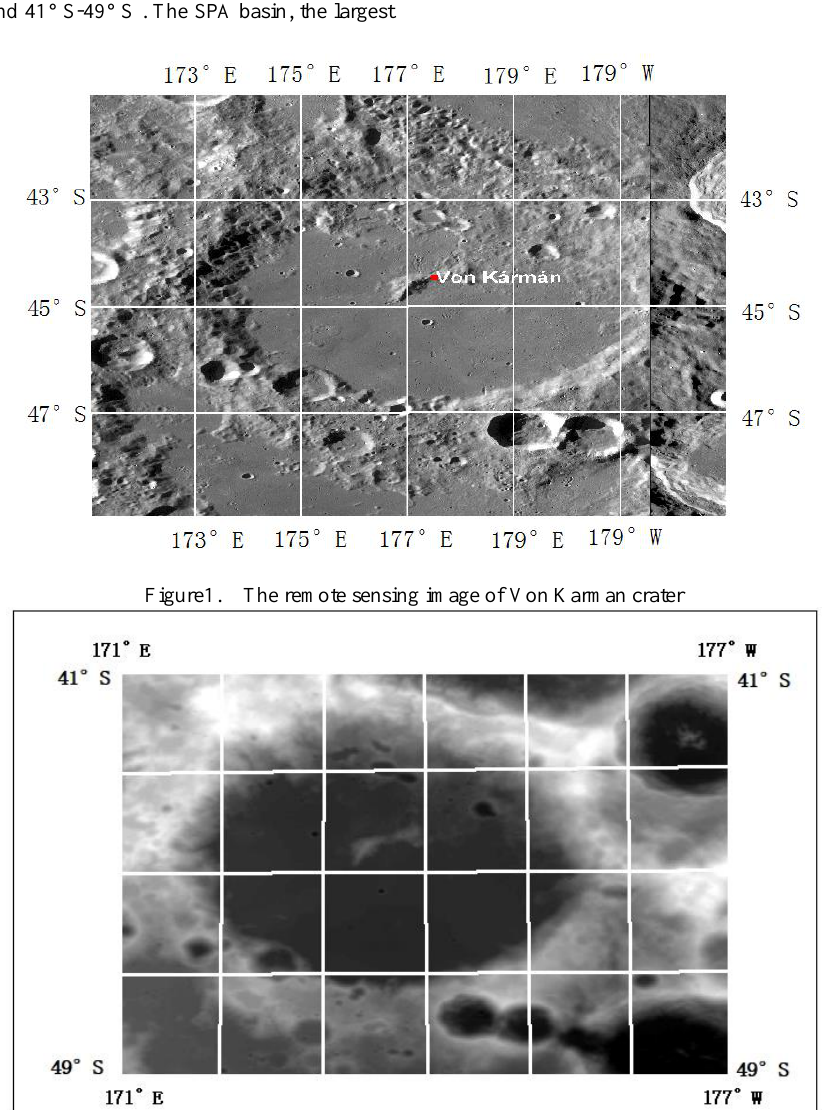
Figure2. Von Karman crater'